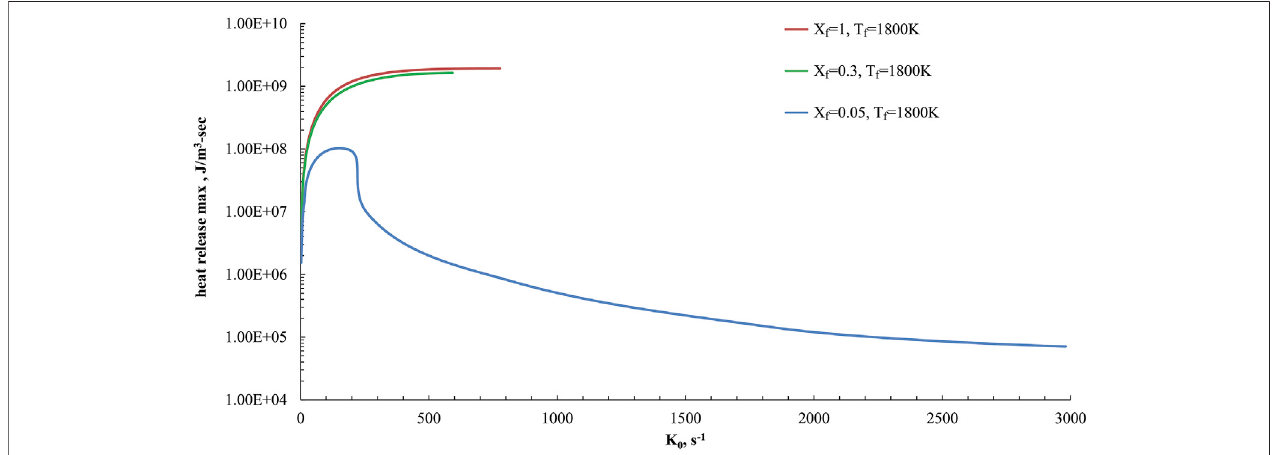
FIGURE5| Maximum value of the heat release pro fi les as a function of K 0 parametric in X f (X f (cid:1) 1, 0.3 and 0.05) in the HFDF con fi guration for T 0 (cid:1) 1,800 K, and P (cid:1) 1 Atm.